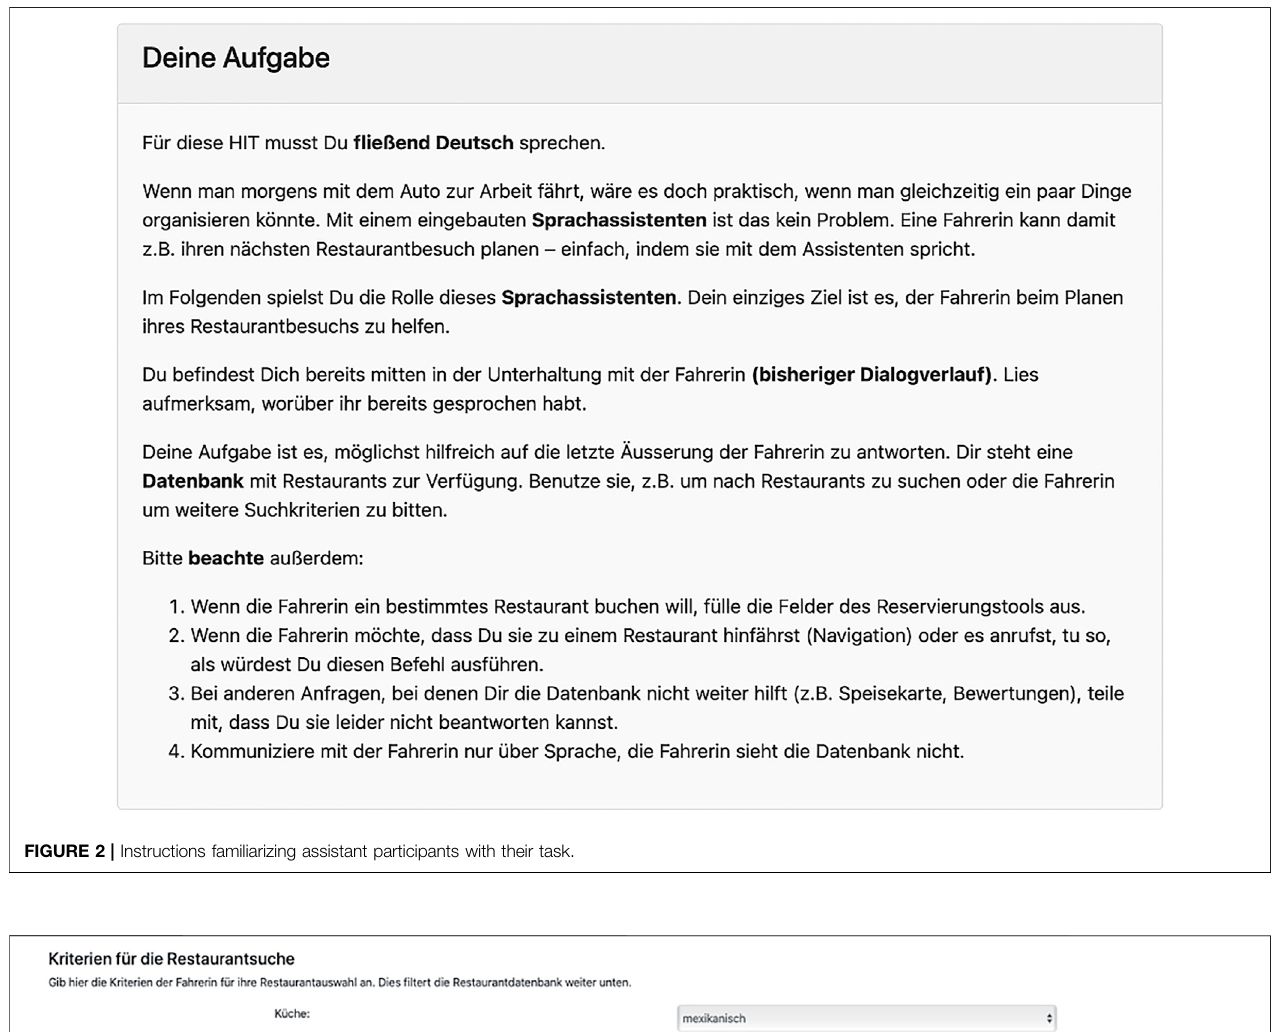
FIGURE 2 | Instructions familiarizing assistant participants with their task.